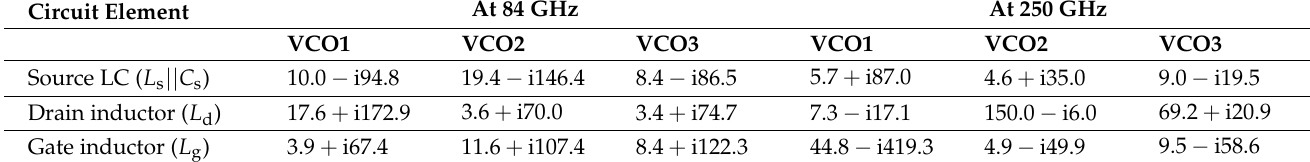
Table 2. Comparison of simulated impedances of VCOs at fundamental and third harmonic frequencies. Circuit Element At 84 GHz At 250 GHz